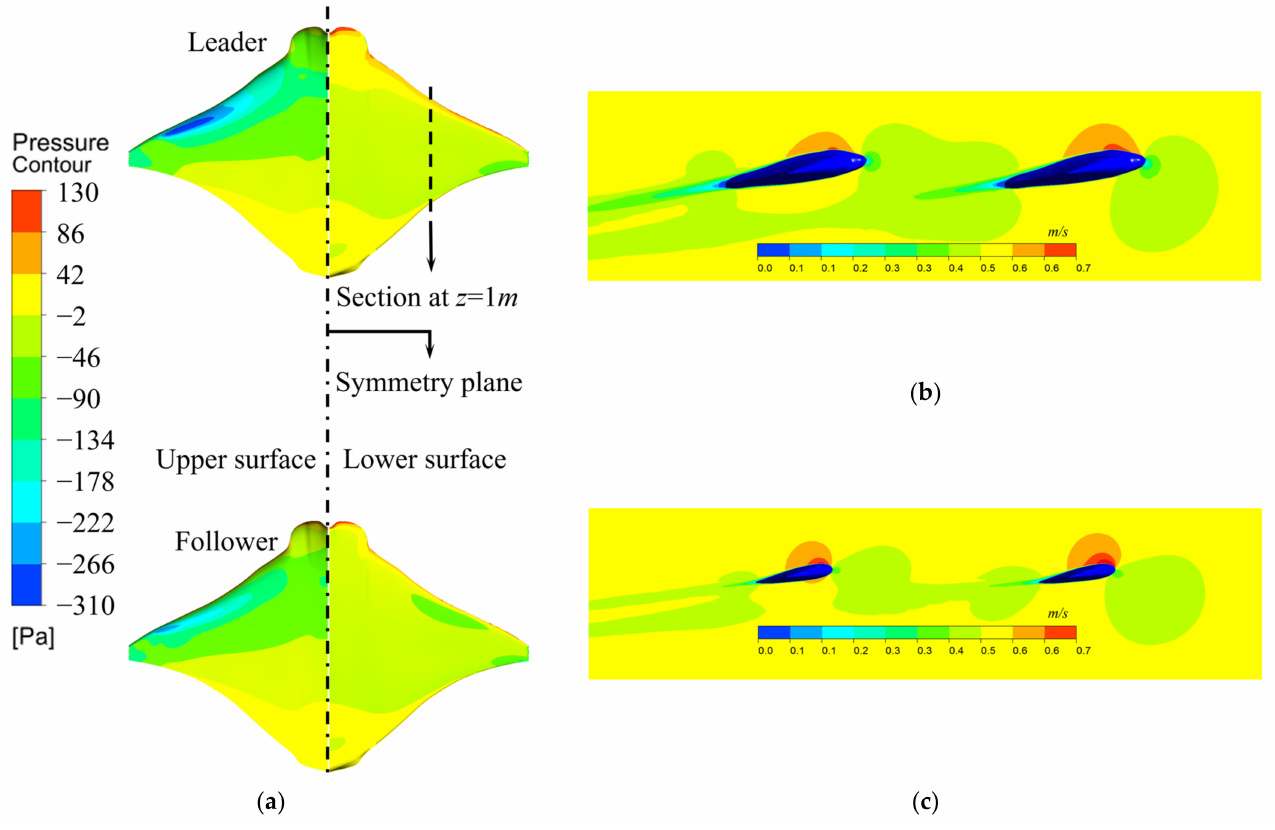
Figure 14. Surface pressure distribution and typical cross-sectional velocity distribution of two manta rays tandem system at α = 8 ◦ , ∆ s = 1 BL. ( a ): Surface pressure distribution. ( b ): Velocity distribution of symmetry plane. ( c ): Velocity distribution of section at z = 1